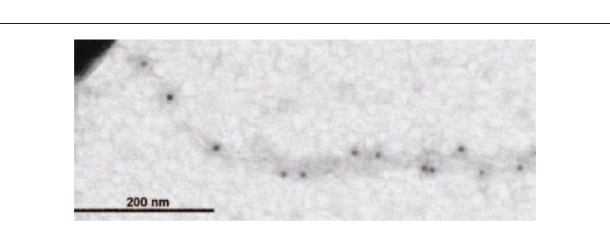
FIGure 4 | Piliation of a gonococcal strain expressing F. novicida derived PilA visualized by immunogold electron microscopy (Salomonsson et al.,